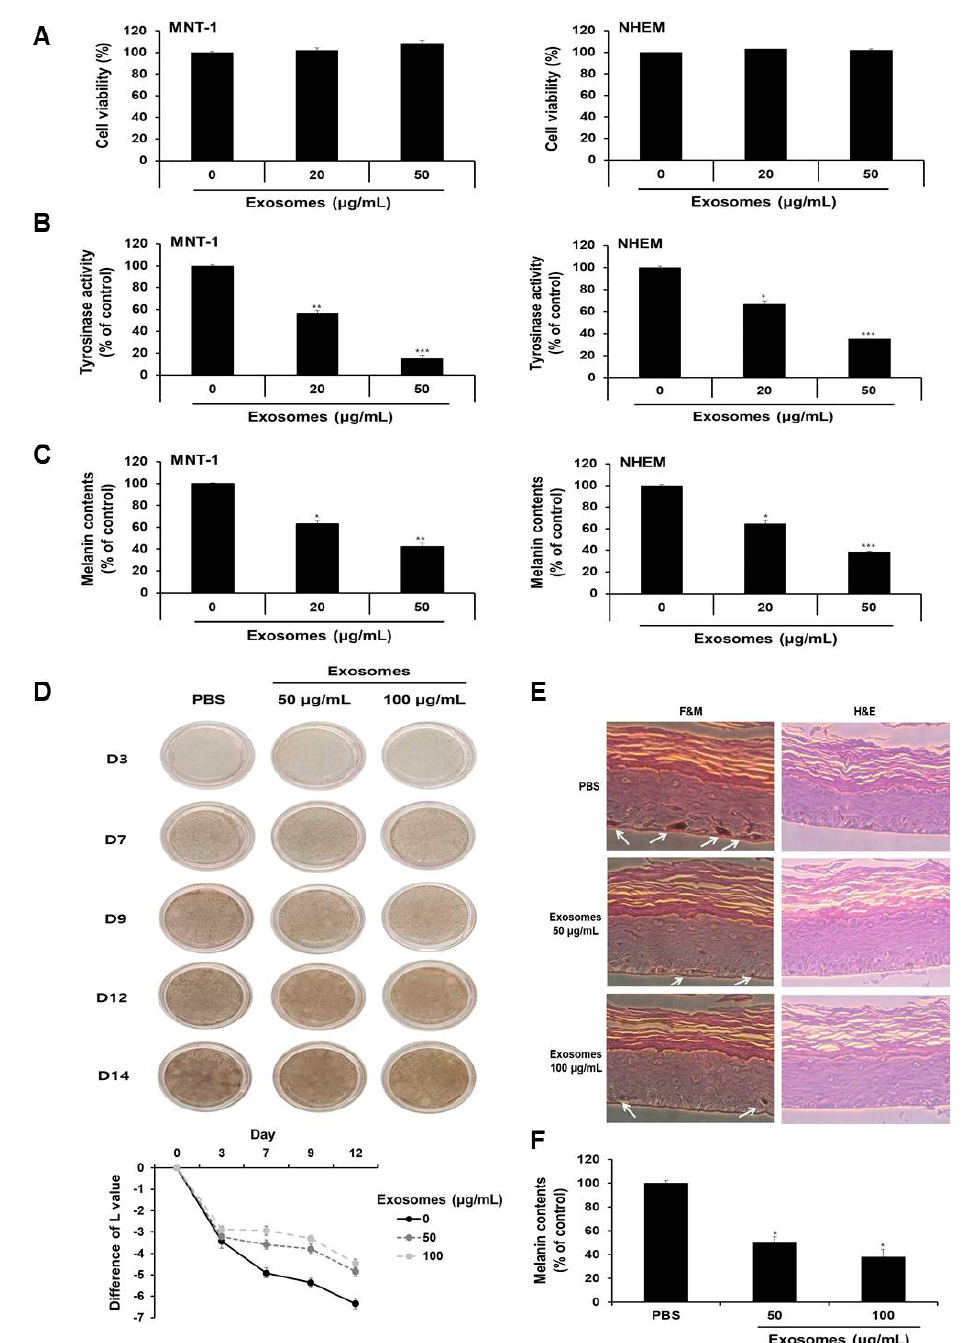
Figure 8. Milk exosomes suppress melanogenesis in human melanoma cells and melanocytes. ( A ) MNT-1 human melanoma cells and NHEM human melanocytes were exposed to 20 or 50 μ g/mL of milk exosomes for 48 h, and cell viability was evaluated by a WST assay. ( B , C ) Tyrosinase activity and melanin contents in the cells treated with milk exosomes were measured; n = 3, ** p < 0.01, *** p < 0.001. ( D ) Human skin tissues (MelanoDerm) were treated with PBS as a control, or 50 or 100 µ g/mL of exosomes, and then photographed. The level of pigmentation in the skin was measured by the L value. ( E ) Paraffin-embedded tissue sections were stained using hematoxylin and eosin (H&E). The melanin pigment of MelanoDerm was visualized by Fontana–Masson staining (F&M). ( F ) Melanin contents were determined in the MelanoDerm tissues exposed to milk exosomes; n = 3, * p <